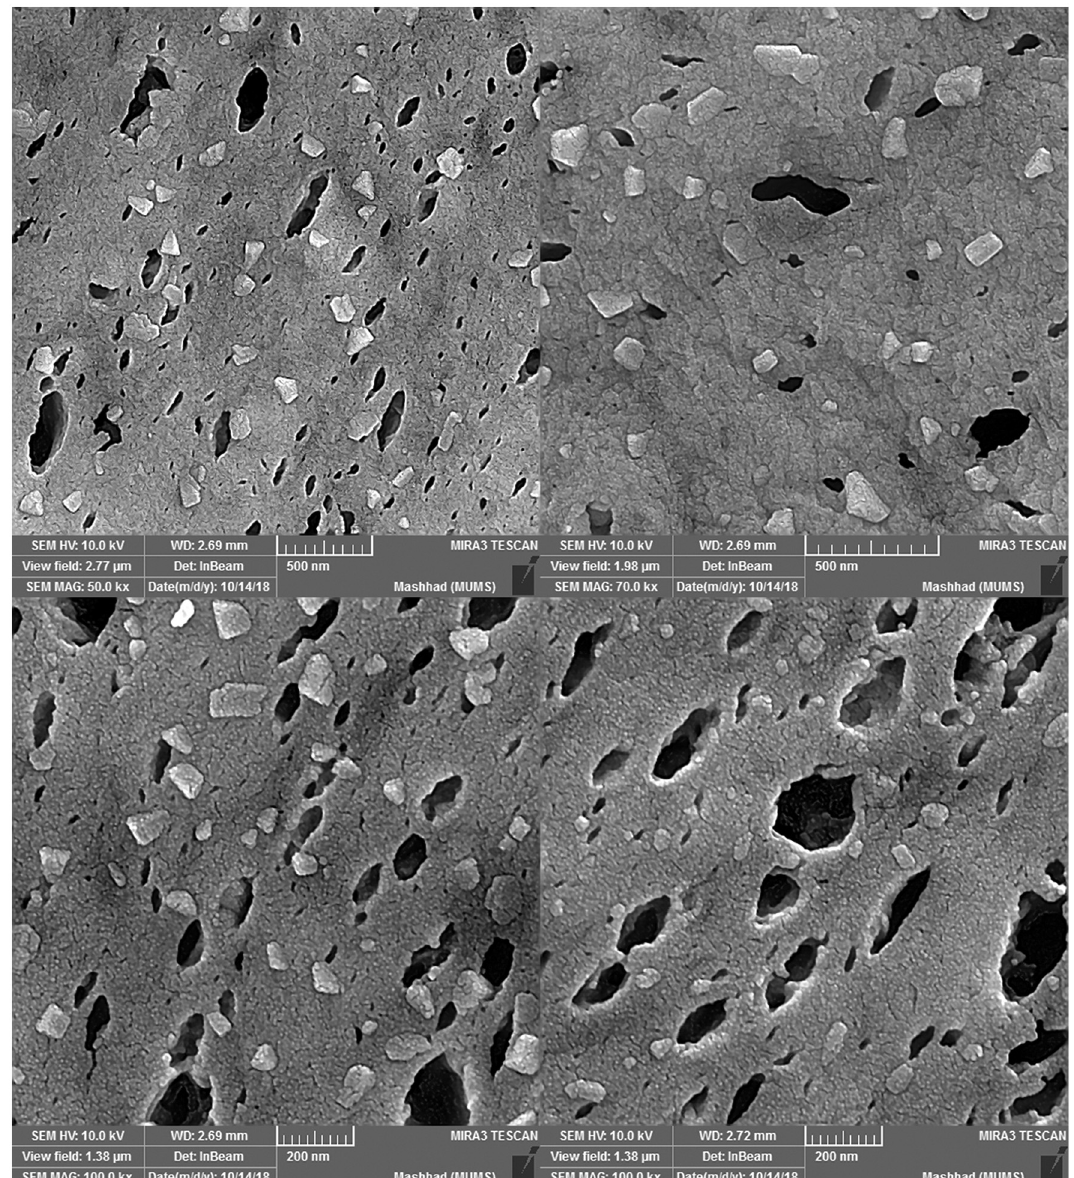
Figure 8: SEM images of SrFe